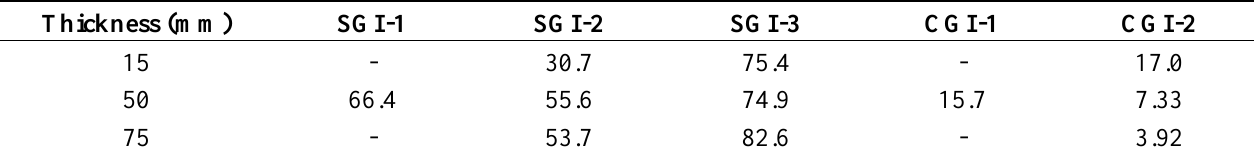
Table 2. Nodularity (%) of samples.